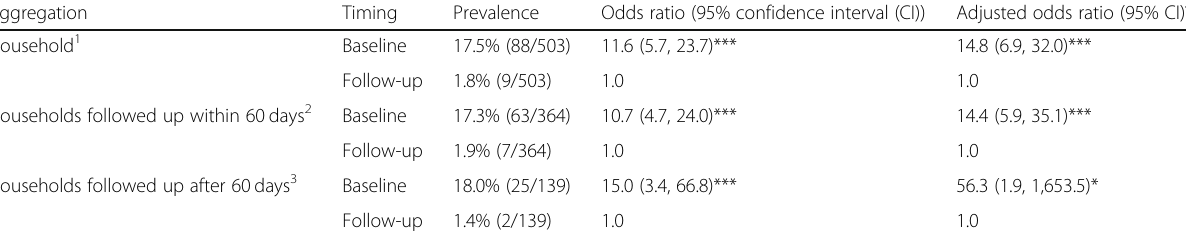
Table 2 Diarrhea prevalence by household at baseline and follow-up separated by days between measurements